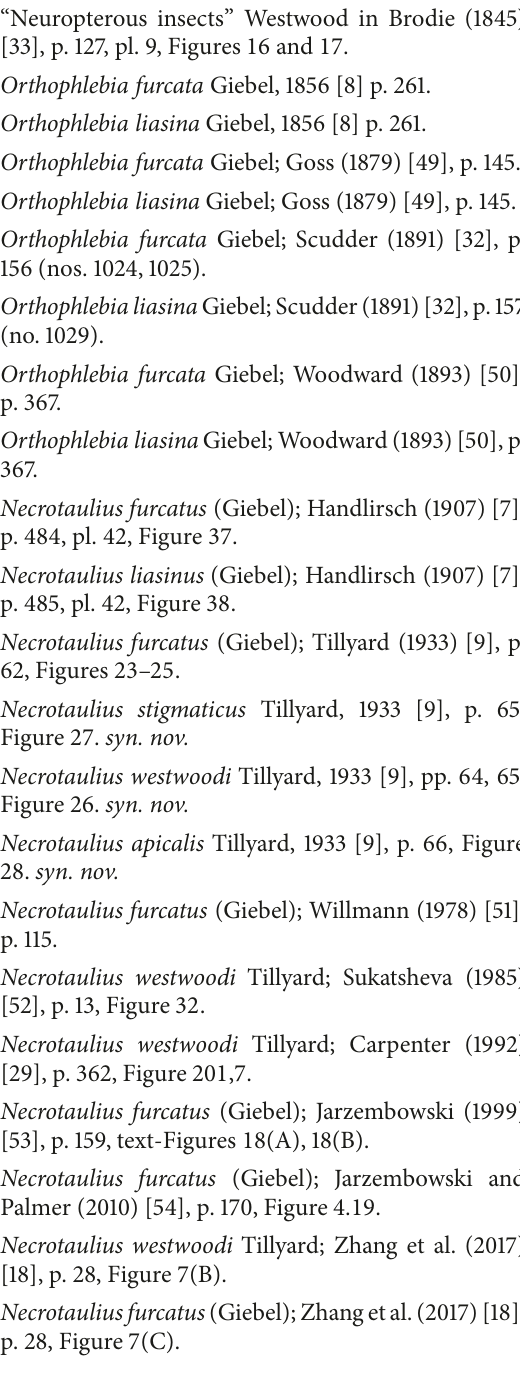
p. 28, Figure 7 (C). Holotype. YORYM YM 815/NHMUK I.11522 (Figure 4)